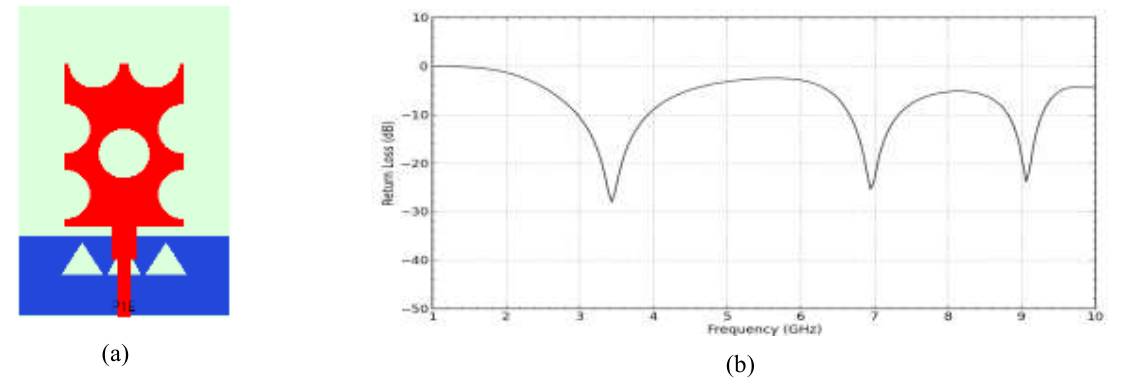
Figure 5: (a) Antenna with three triangle shaped defects and (b) its return loss (simulated)